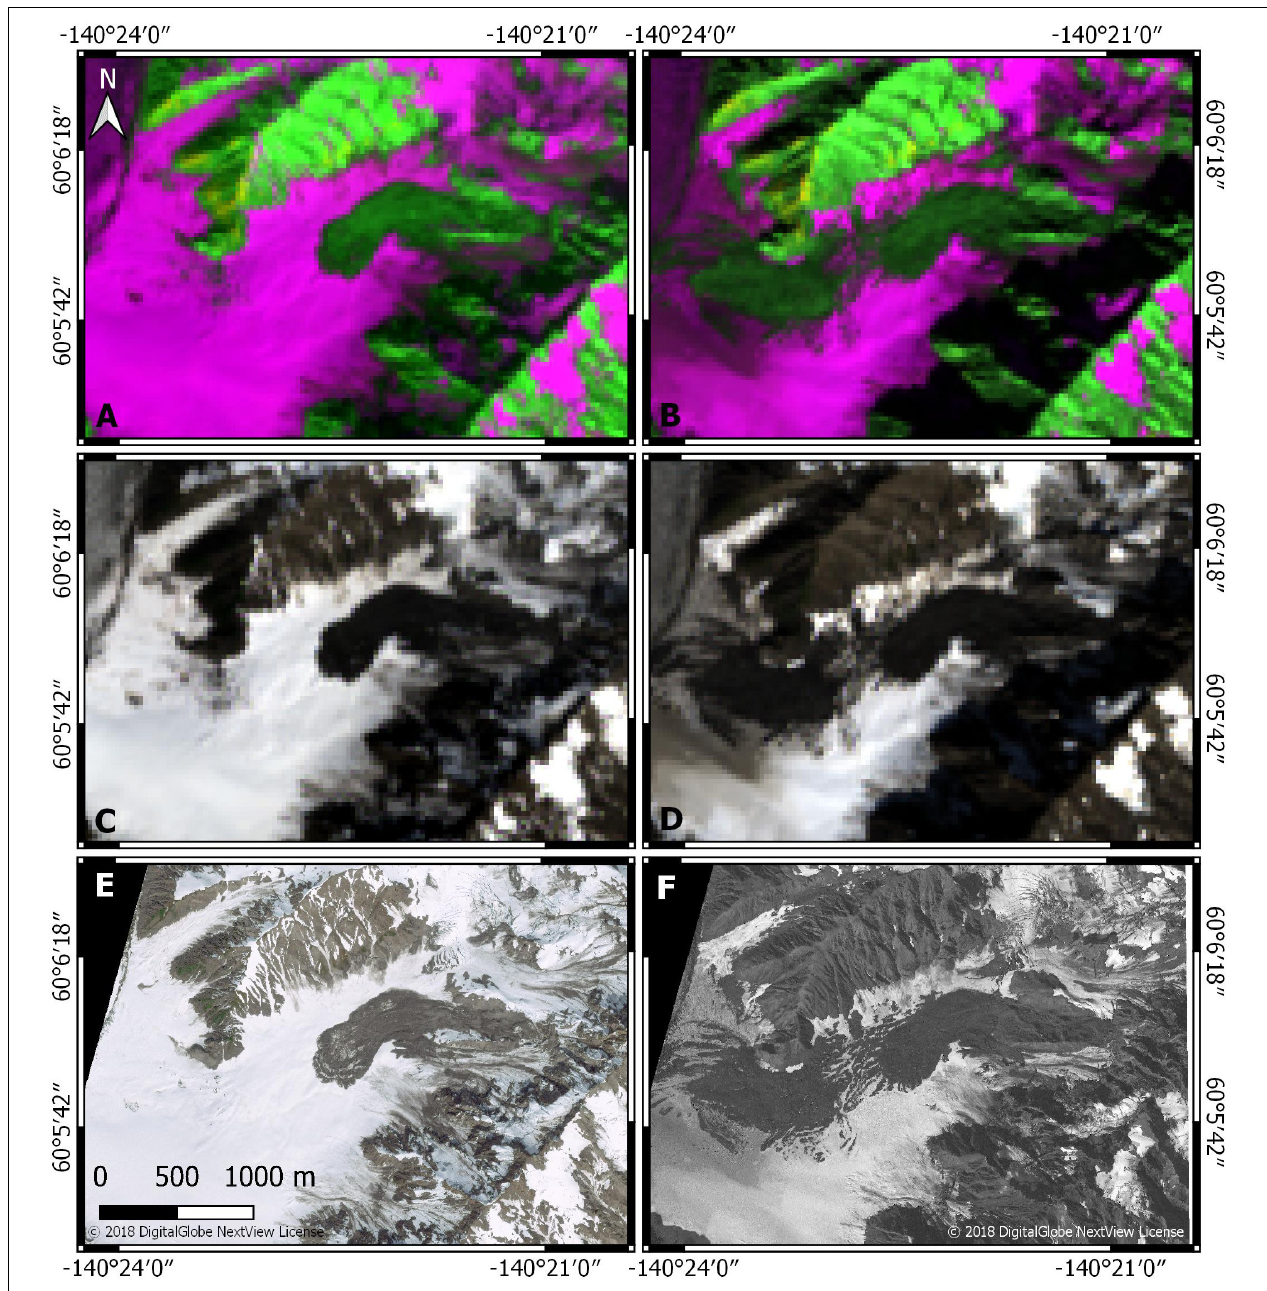
FIGURE 2 | (A) Landsat image acquired on 24 July 2018 (false color band combination RGB = 564) showing a fresh rock avalanche deposit (RA 212, event occurred between 8 June 2018 and 1 July 2018) and older rock avalanche deposits buried under snow on the surface of Hitchcock Glacier. (B) Landsat image acquired on 3 September 2018 showing the deposit of RA 212 starting to degrade and older rock avalanche deposits that have been uncoved by snow. (C,D) True color images of (A,B) , respectively. DigitalGlobe satellite images that were collected at similar times are shown in parts (E) 5 July 2018 and (F) 4 September 2018 for